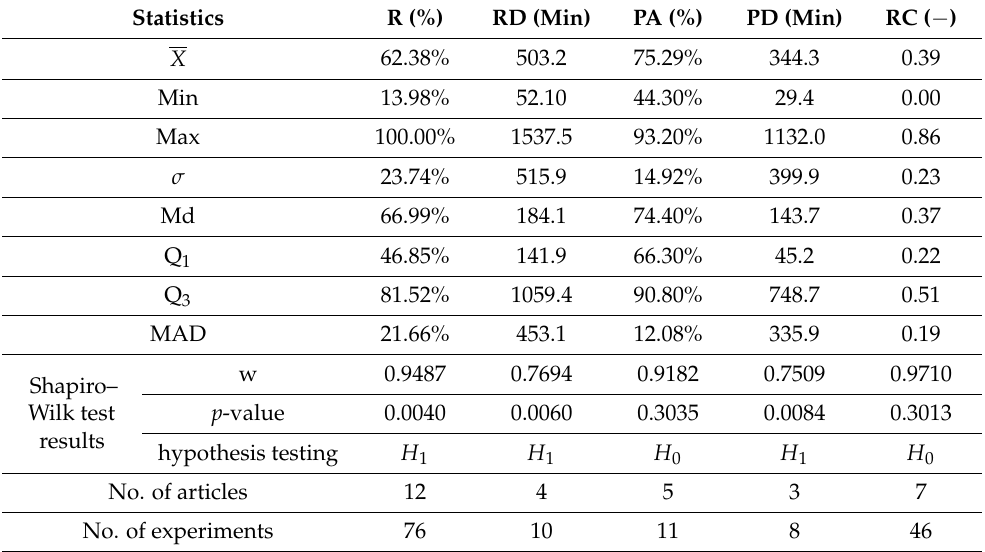
Table 4. Average rainfall retention (%), runoff delay (min), peak attenuation (%), peak delay (min), and runoff coefficient ( − ) summary statistics for the Mediterranean climate (rainfall simulations are not included in the results) and Shapiro–Wilk test